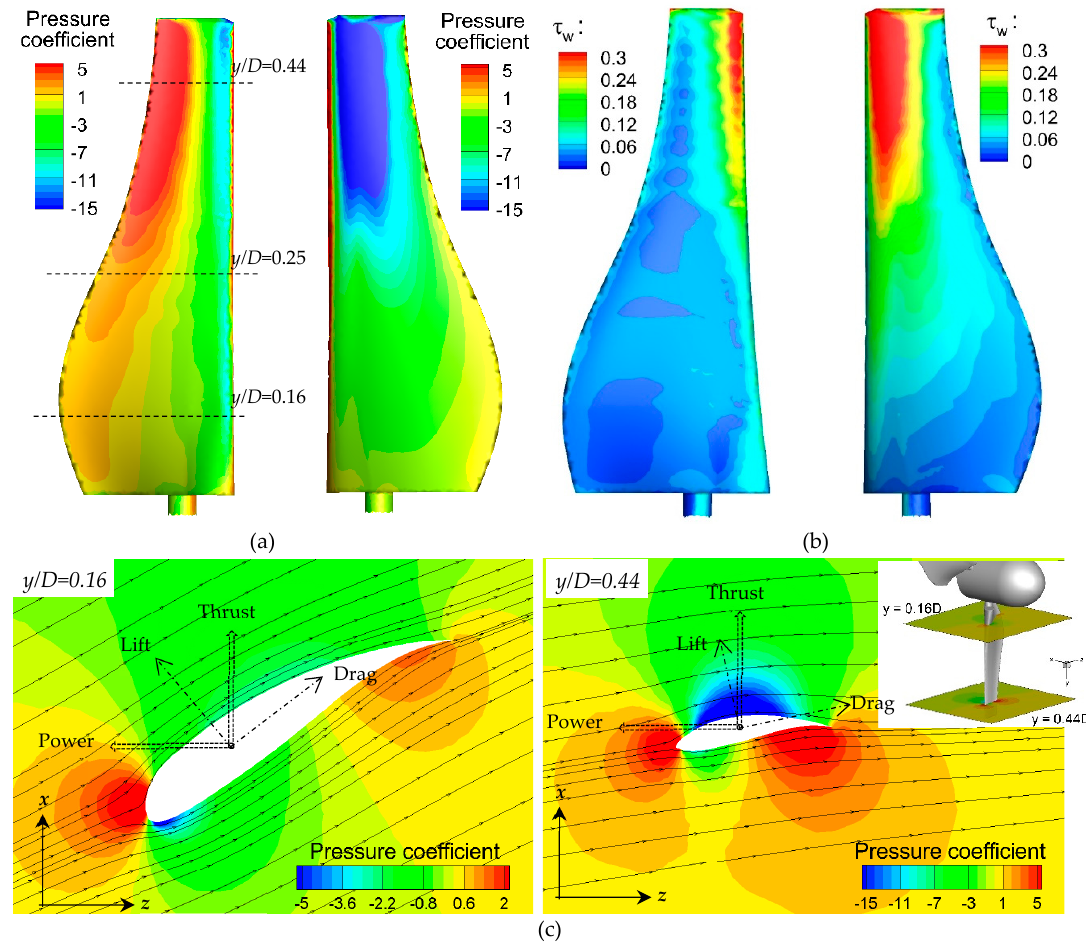
Figure 5. Blade surface ( a ) pressure and ( b ) shear stress magnitude distribution on windward face (left panel) and leeward face (right panel) obtained using URANS. ( c ) Flow predictions around the turbine blade close to the root ( y = 0.16 D ) (left panel) and close to the tip ( y = 0.44 D ) (right panel). The inset plot shows the plane location with respect to the turbine blade.